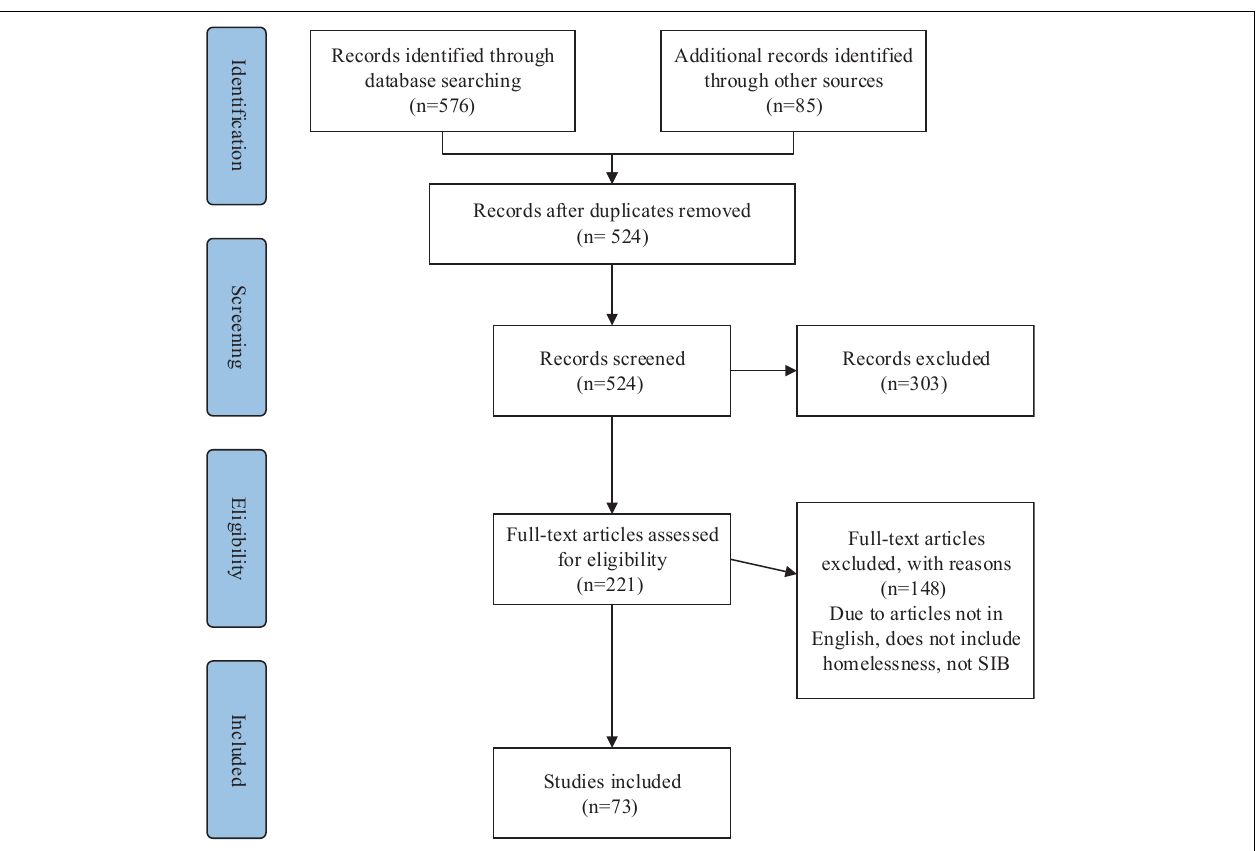
FIGURE 1 | PRISMA flow diagram of screening process and outcome (Moher et al.,